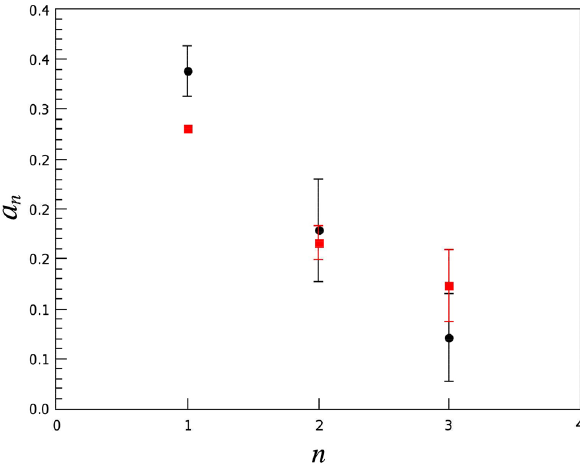
Fig. 15 Calculations of moments of the ρ structure function Eq. (54). Round black points for lattice results. Squared red points for model calculations obtained within the holographic model of Refs. [37,68,69] and including variations of 0 . 35 ≤ κ ≤ 0 . 6